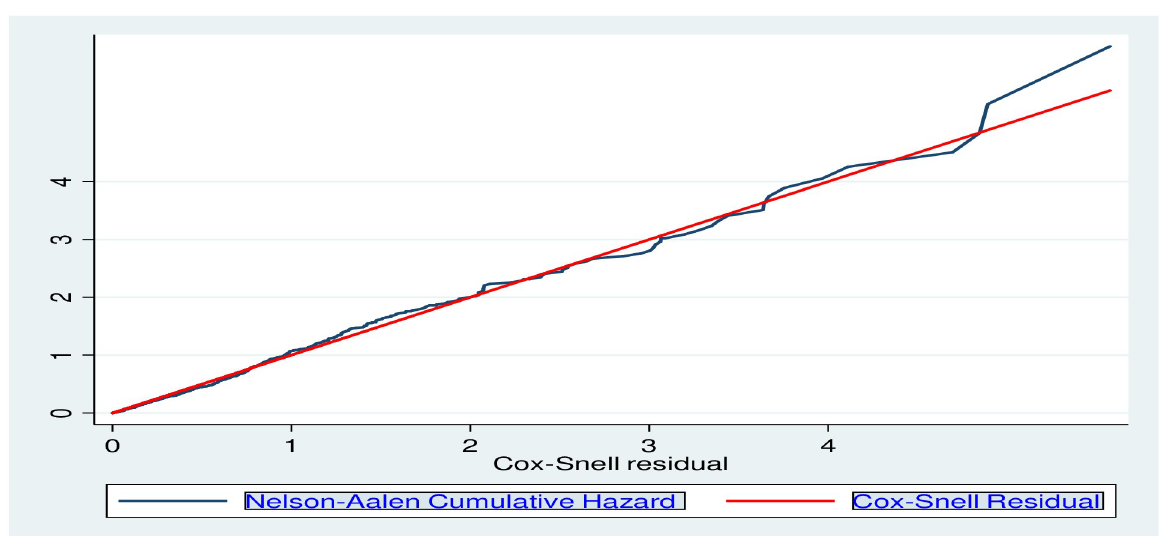
Fig 1. Model fitness by using Cox-Snail residual test to identify the incidence and predictors of time to recovery among SAM children at SPHMMC, Addis Ababa, Ethiopia, 2019.